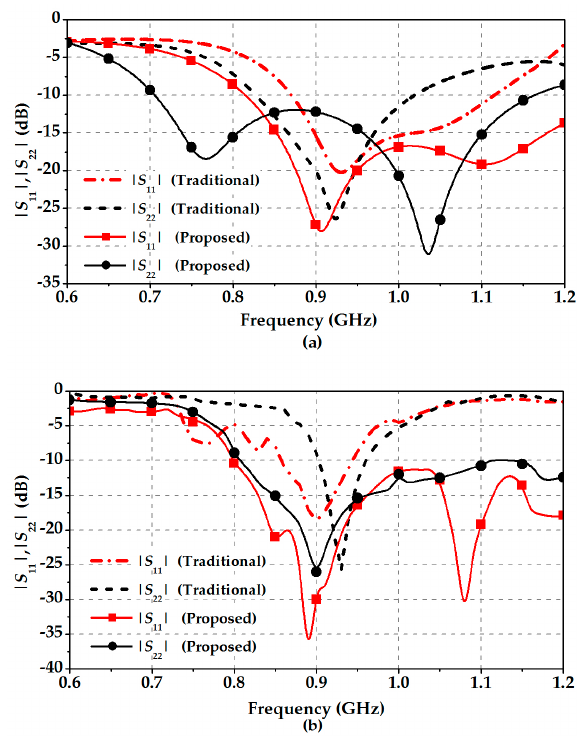
Figure 8 . | S 11 | and | S 22 | of the traditional and proposed circuits: ( a ) simulation and ( b ) measurement.